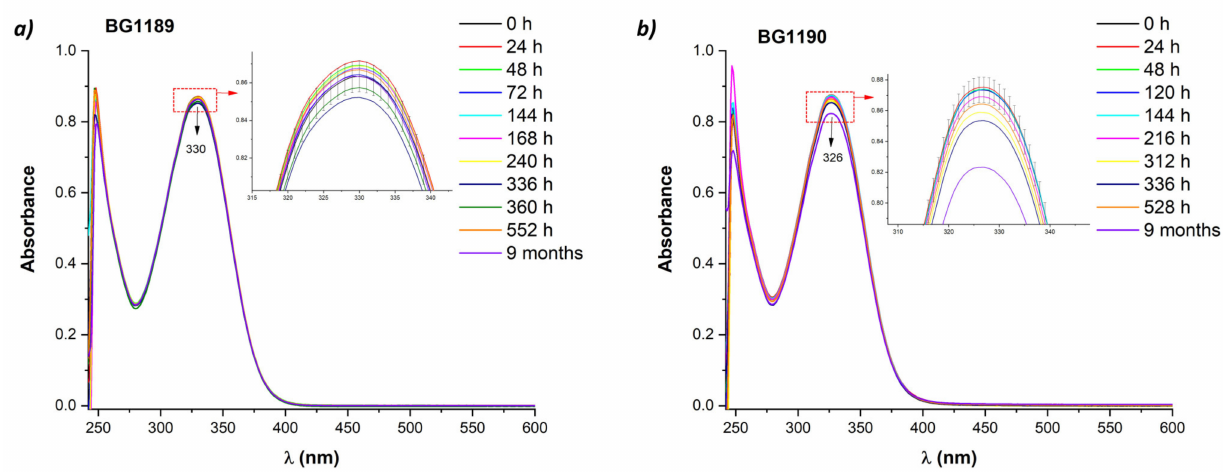
Figure 3. Time evolution of absorption spectra of quinazoline derivatives: ( a ) BG1189 and ( b ) BG1190. Solutions prepared in dimethyl sulfoxide (DMSO) at 10 − 3 M; kept in dark, at 22 ◦